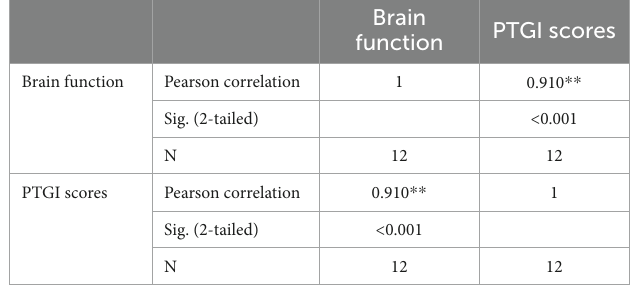
TABLE 4 Pearson correlation for brain function and PTG during EMDR.